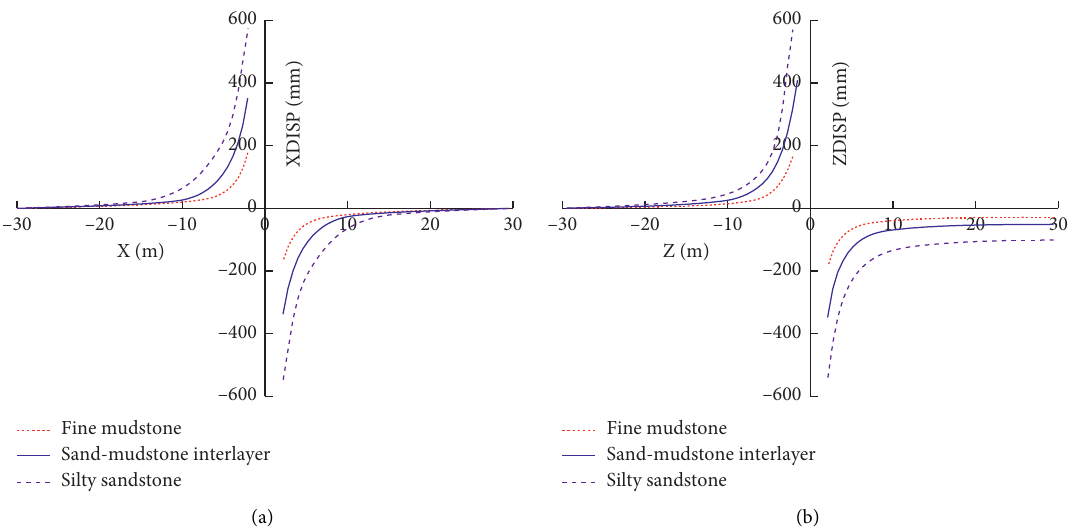
Figure 9: Distribution laws of displacement on the monitoring line under different lithology conditions. (a) Vertical survey line. (b) Horizontal survey line.